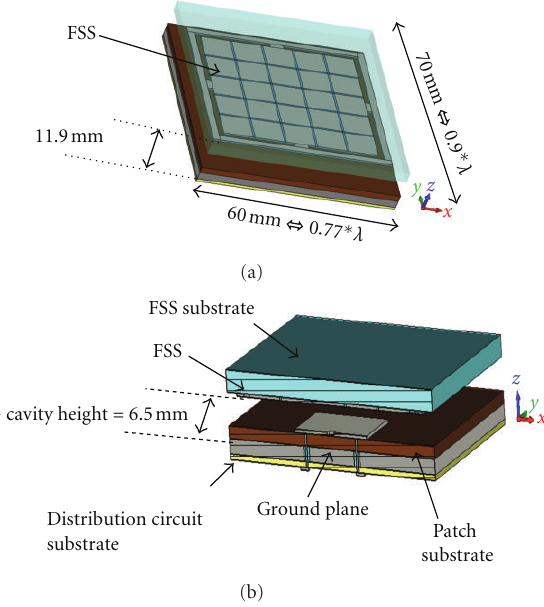
Figure 1: Top (a) and inside (b) views of the designed low-profile EBG